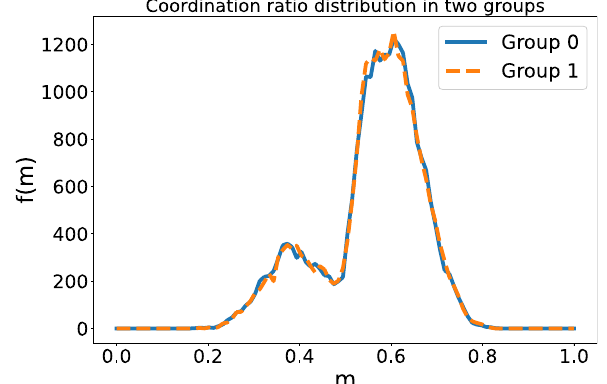
Figure 9. Coordination ratio for group 0 and for group 1.